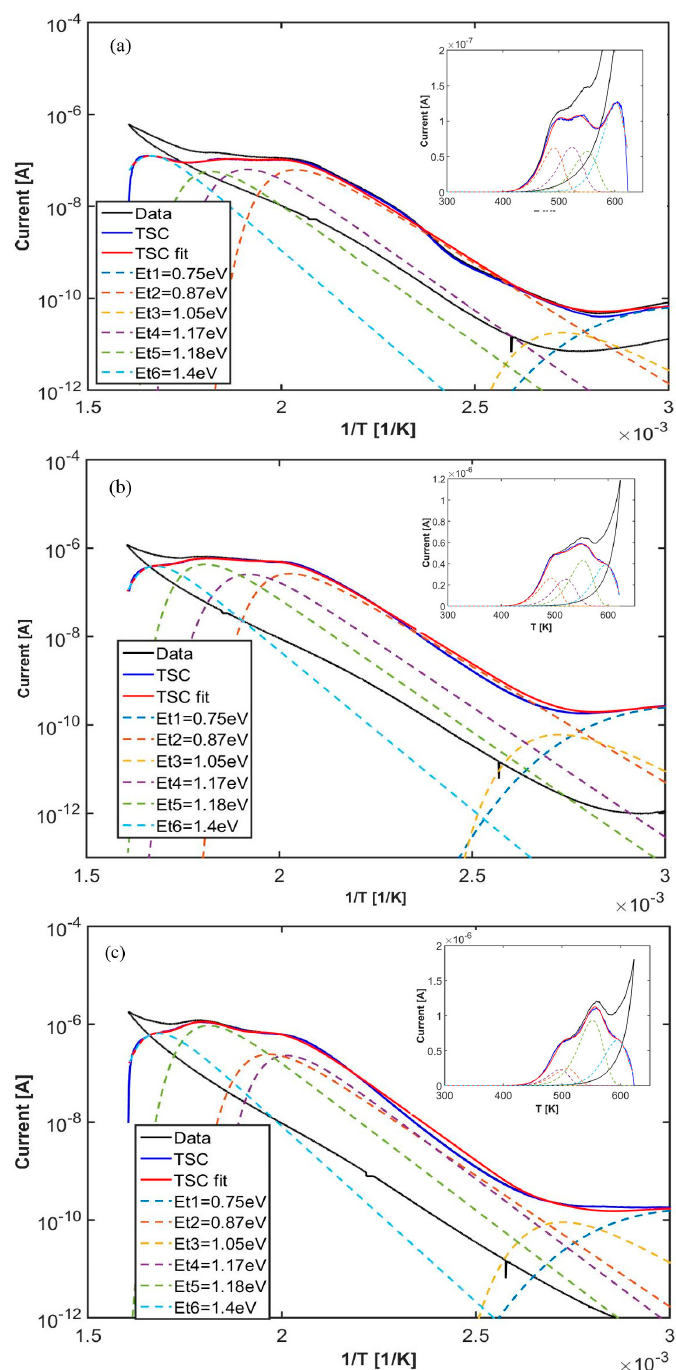
Figure 11. TSC response after priming in He atmosphere with a pressure in chamber ( a ) 1 bar; ( b ) 10 − 3 bar ( c ) 10 − 6 bar. TSC experimental data (black); Blue: TSC heating scan subtracted from background (cooling stage); dotted curves: TSC peaks convoluted with a gaussian, parameters are given in Table 2.